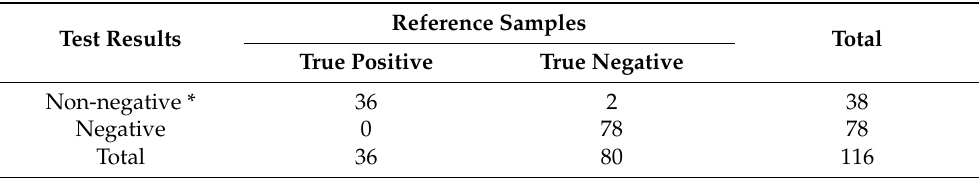
Table 7. Qualitative results of ERADIKIT™ BMSK PLUS obtained using the reference samples panel: cross-tabulation according to the true IBR status of the reference